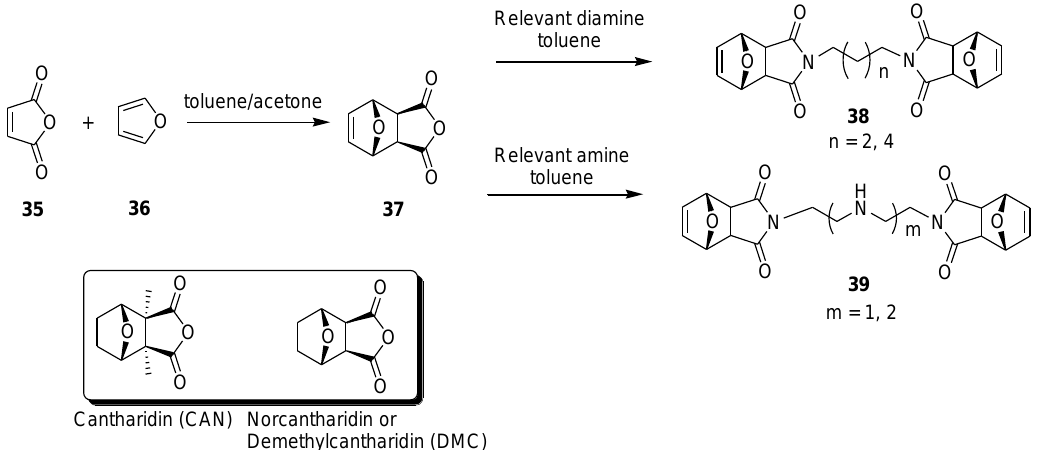
Figure 9. Synthesis of four unsaturated bis-norcantharimides: dimers 38 and 39 .